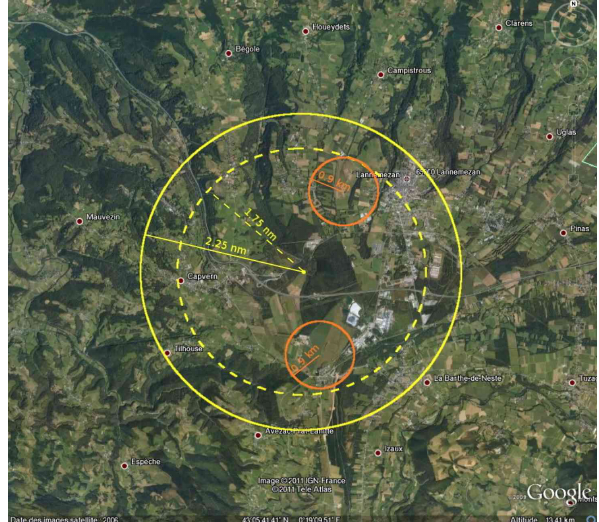
Figure 1. The temporary restricted area activated for the RPAS op- erations during the BLLAST campaign. The solid yellow line indi- cates the outer boundary of the 2.25 nautical mile (nm) zone re- served and the dashed one the 1.75nm, finally available for the RPAS operations due to an additional required safety buffer towards general airspace. The two small circles indicate the zones around the Sites 1 and 2, where all RPAS operations took